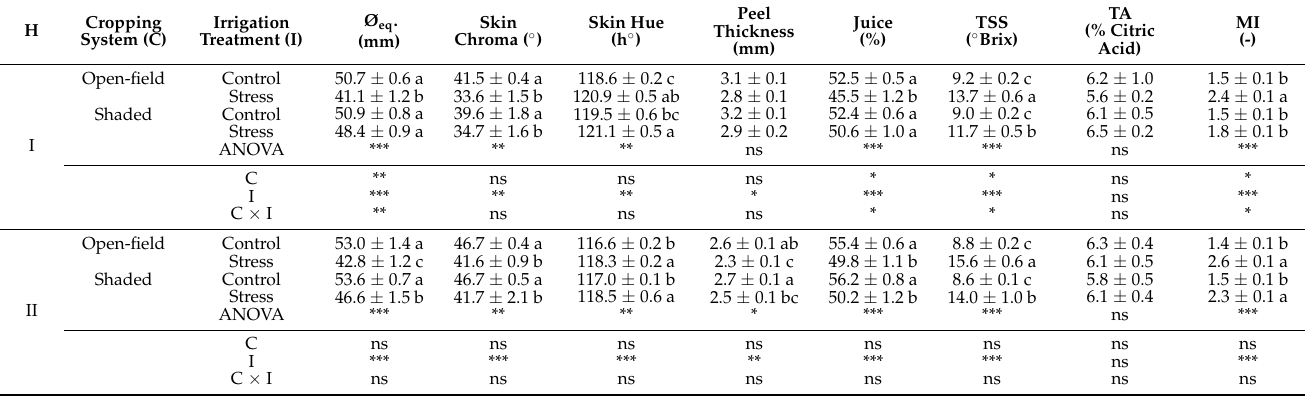
Table 4. Physico-chemical fruit quality traits of control and stressed lime trees grown in open-field and shaded conditions, at the two harvest dates (H): I (DOY 230) and II (DOY 267). H Cropping System (C) Irrigation Treatment